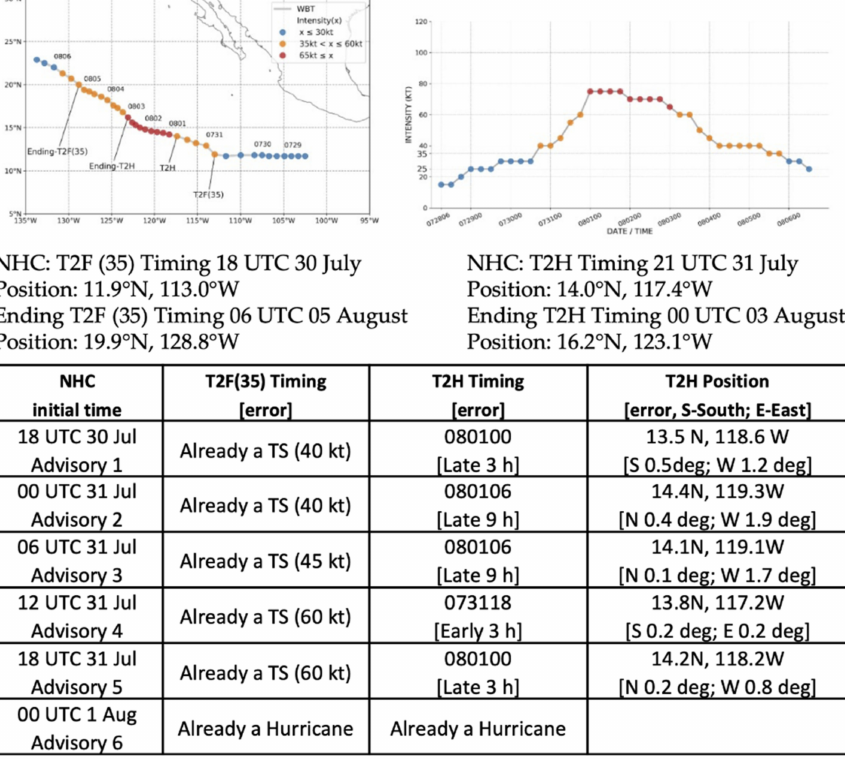
Figure 10. National Hurricane Center (NHC) forecasts of the T2F(35) and the T2H timing and positions based on NHC advisories as in Figure 4 except here during